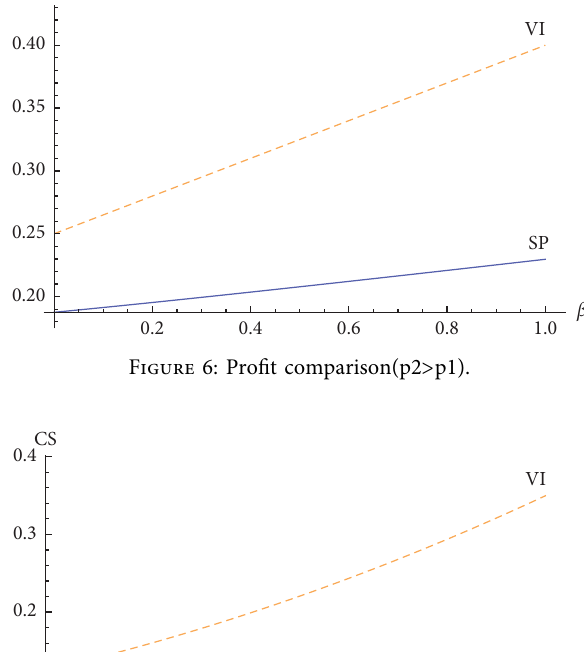
Figure 5: Channel price gap comparison (p2 > p1).